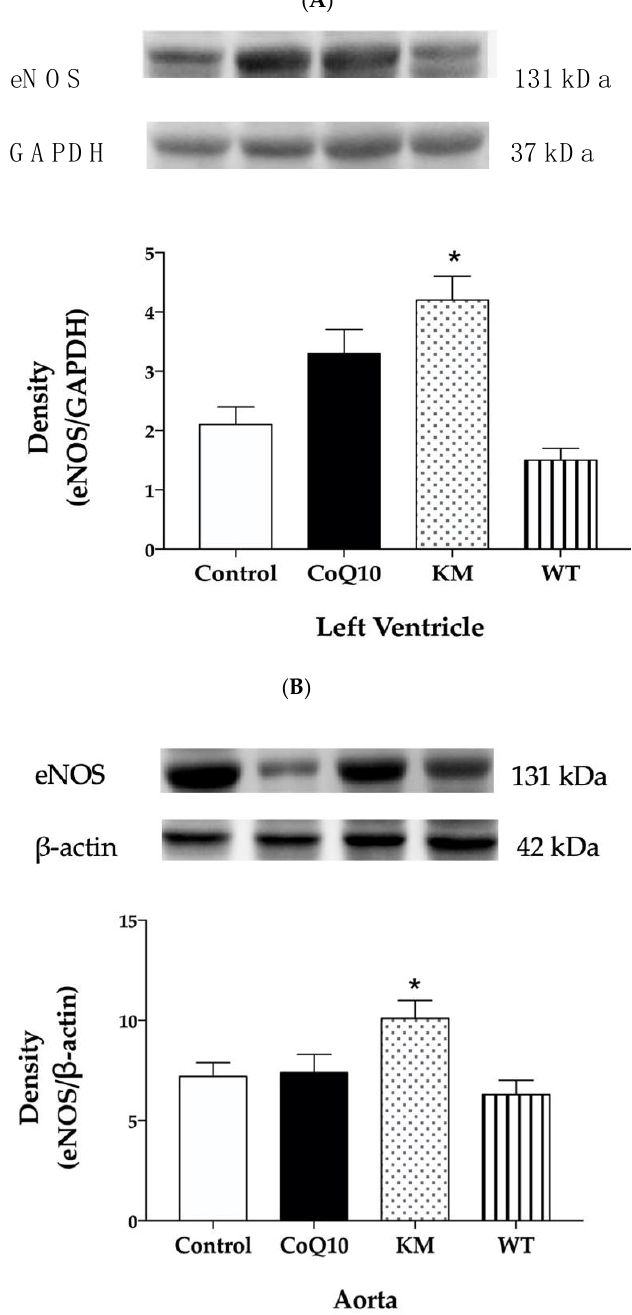
Figure 2. Effect of CoQ10, KM, and WT on eNOS protein expression in the left ventricle (LV) ( A ) and aorta ( B ). CoQ10—coenzyme Q10, KM—Koralovij Marka, WT—Wild Type. Data are means ± SEM from 6 animals in each group. * p < 0.05 compared to the control group.